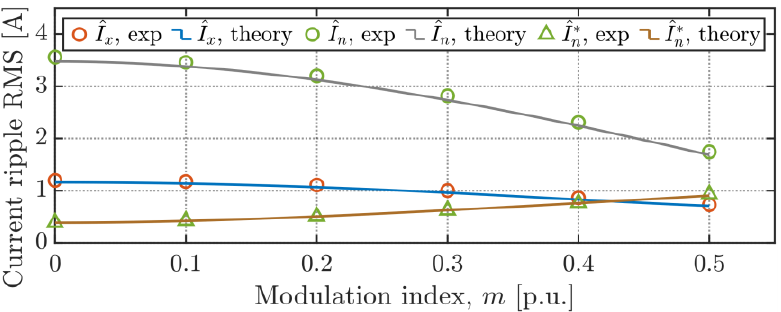
Figure 16. Experimental (markers) and theoretical (solid lines) current ripple RMS as a function of the modulation index m of phase ( x ) and neutral currents in case of single and three interleaved (“*”) carriers.